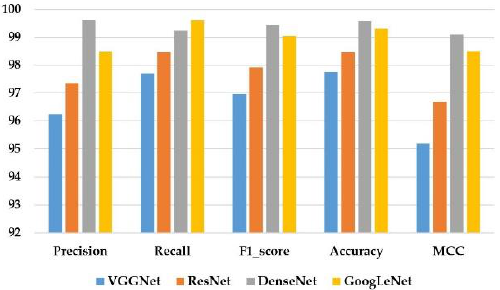
Figure 16. Casting product classification performance in testing phase. Table 7. Casting product classification performance.